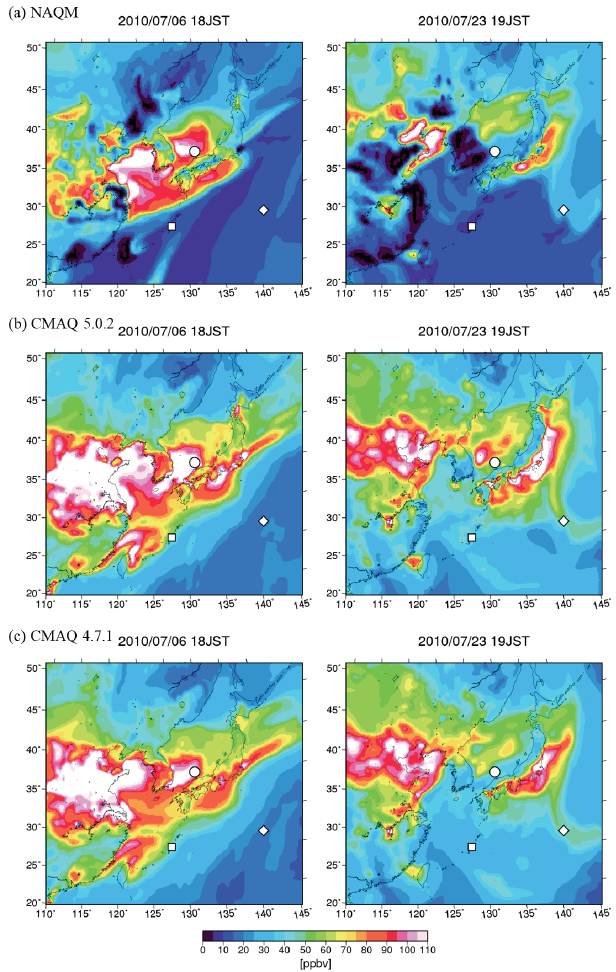
Figure 4. Spatial distribution of surface O 3 over northeastern Asia at 18:00JST on 6 July (left) and 19:00JST on 23 July (right) 2010 simulated by (a) NAQMS, (b) CMAQ 5.0.2, and (c) CMAQ 4.7.1. Markers denote the locations of observation sites.